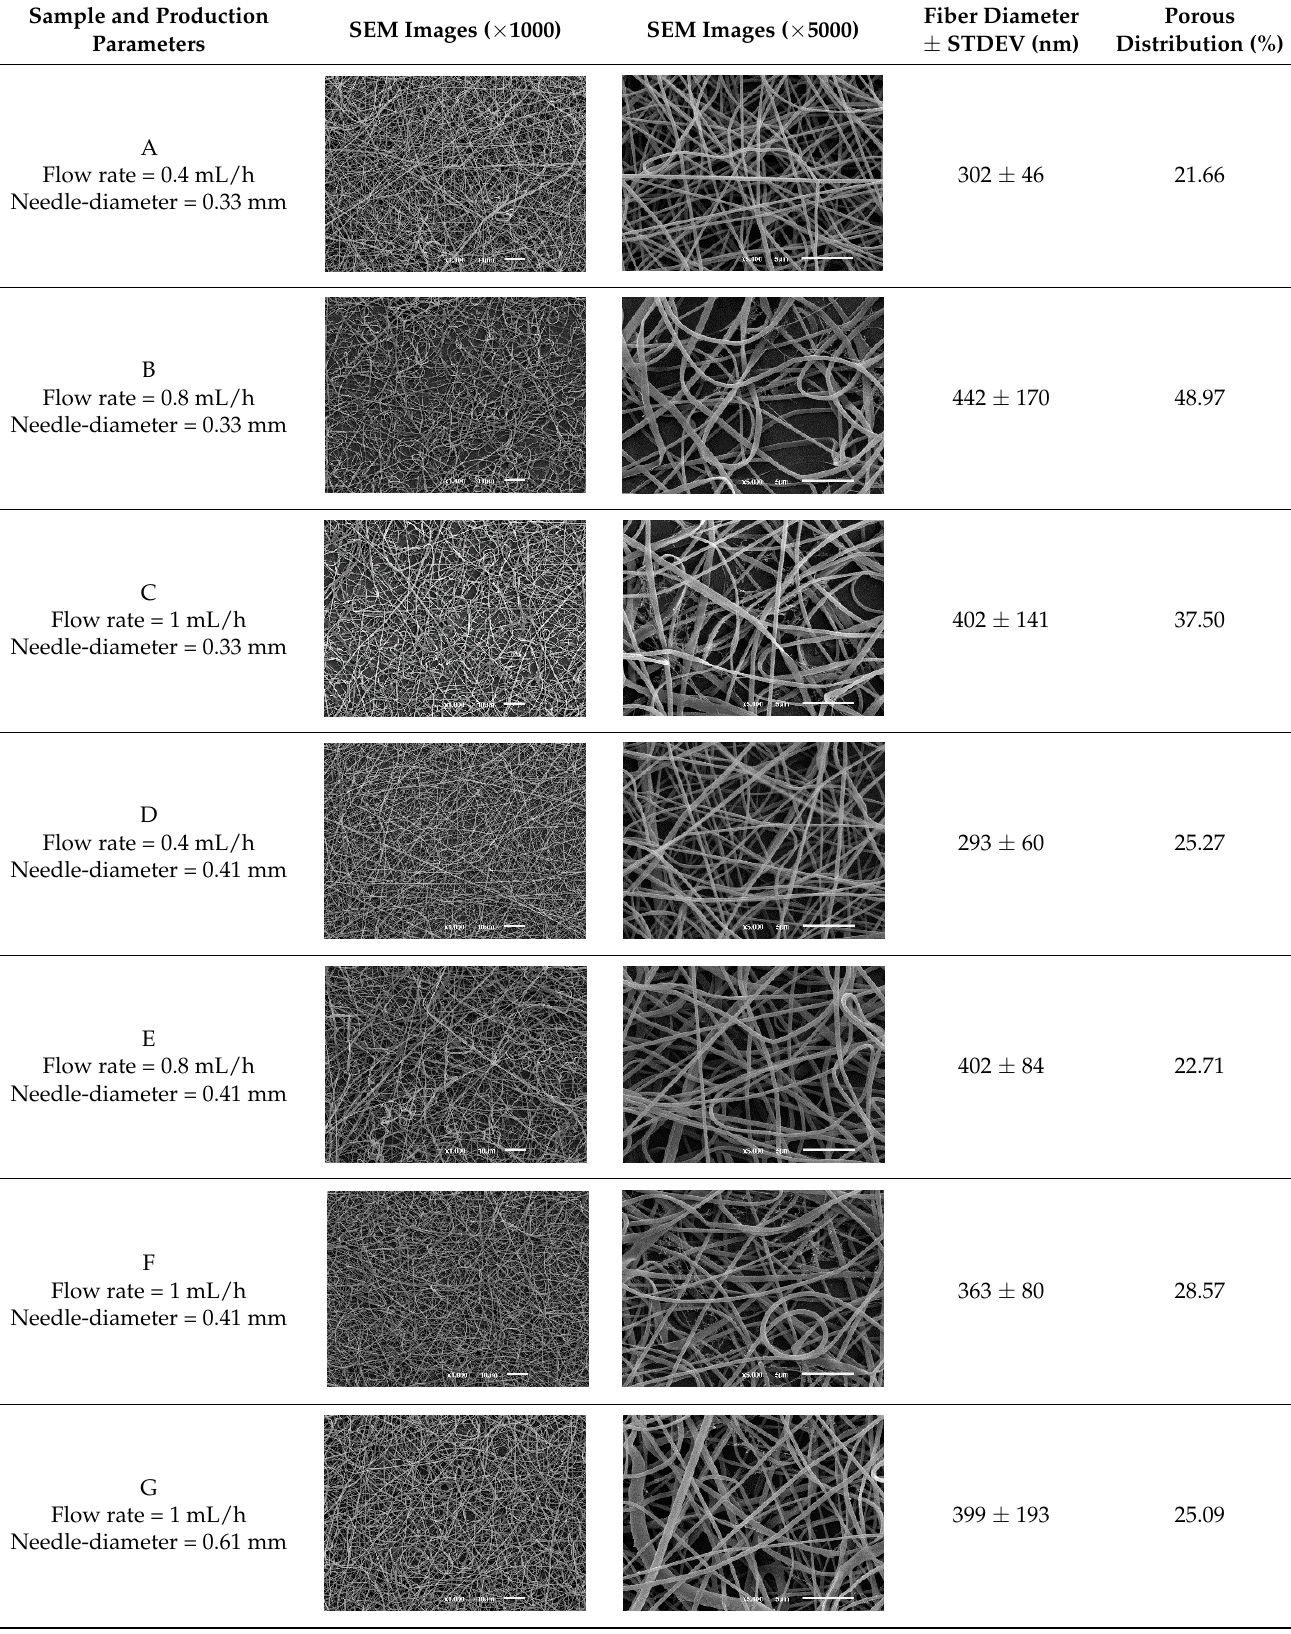
Table 4. SEM images of the produced PA nanofibres and corresponding characteristics.